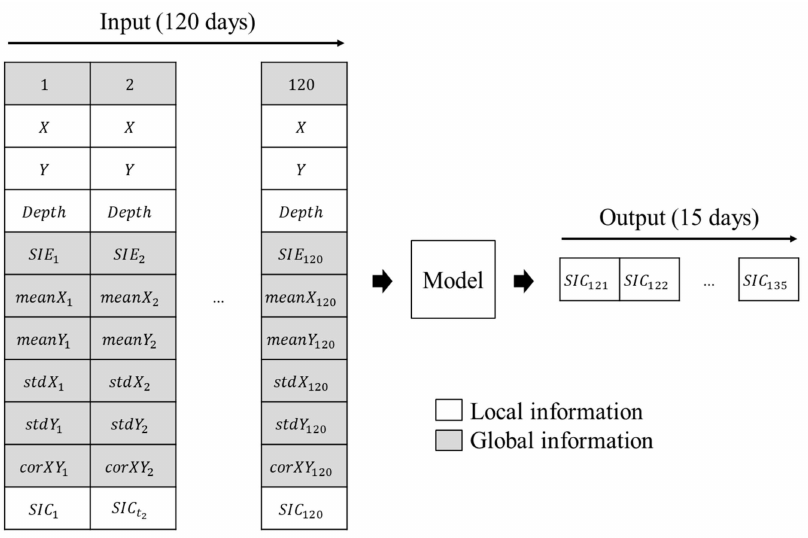
Figure 2. Artificial neural network input and output.